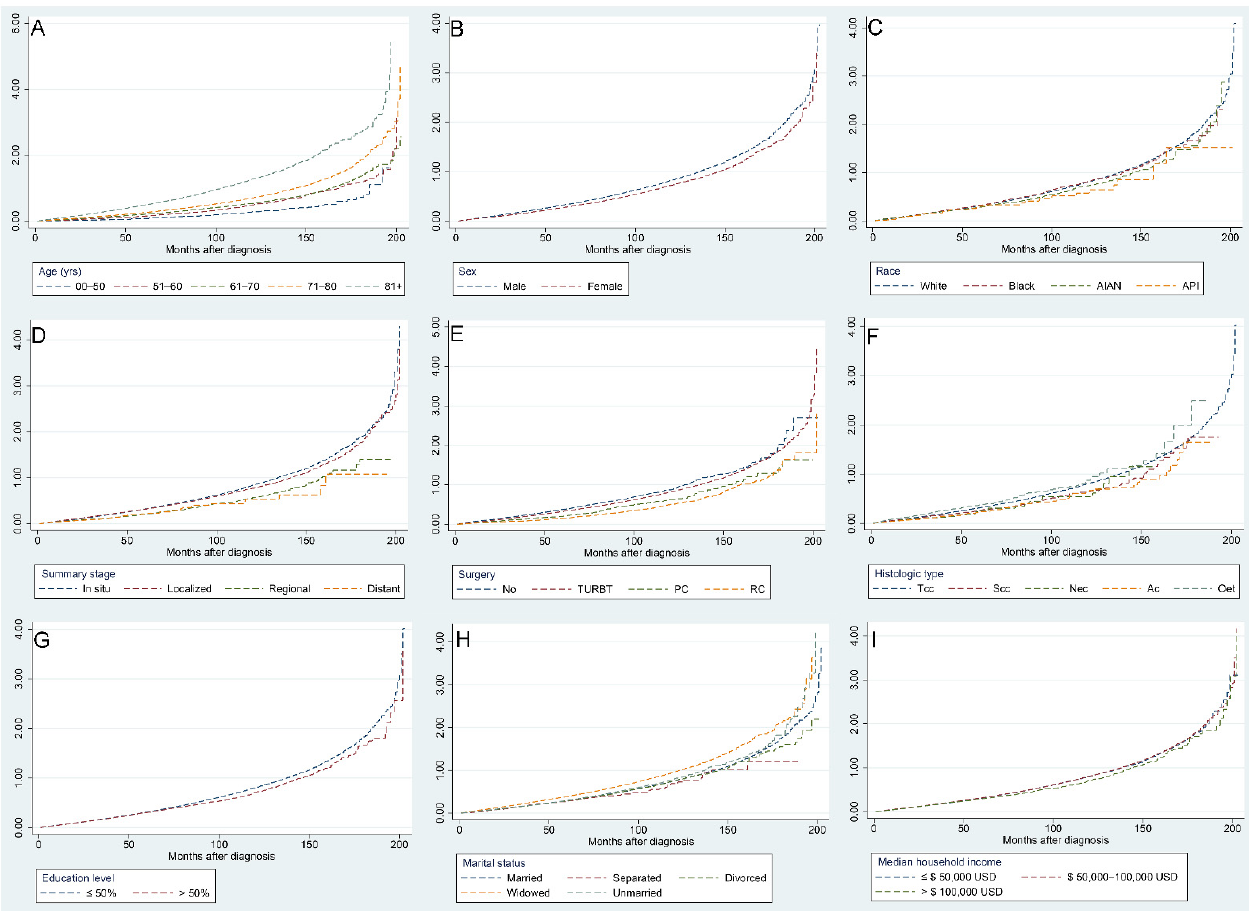
Figure 5. Independent Nelson–Aalen cumulative hazard curves for various factors of cardiovascular mortality in bladder cancer patients: age ( A ), sex ( B ), race ( C ), summary stage ( D ), surgery ( E ), histologic type ( F ), education level ( G ), marital status ( H ), and median household income ( I ).